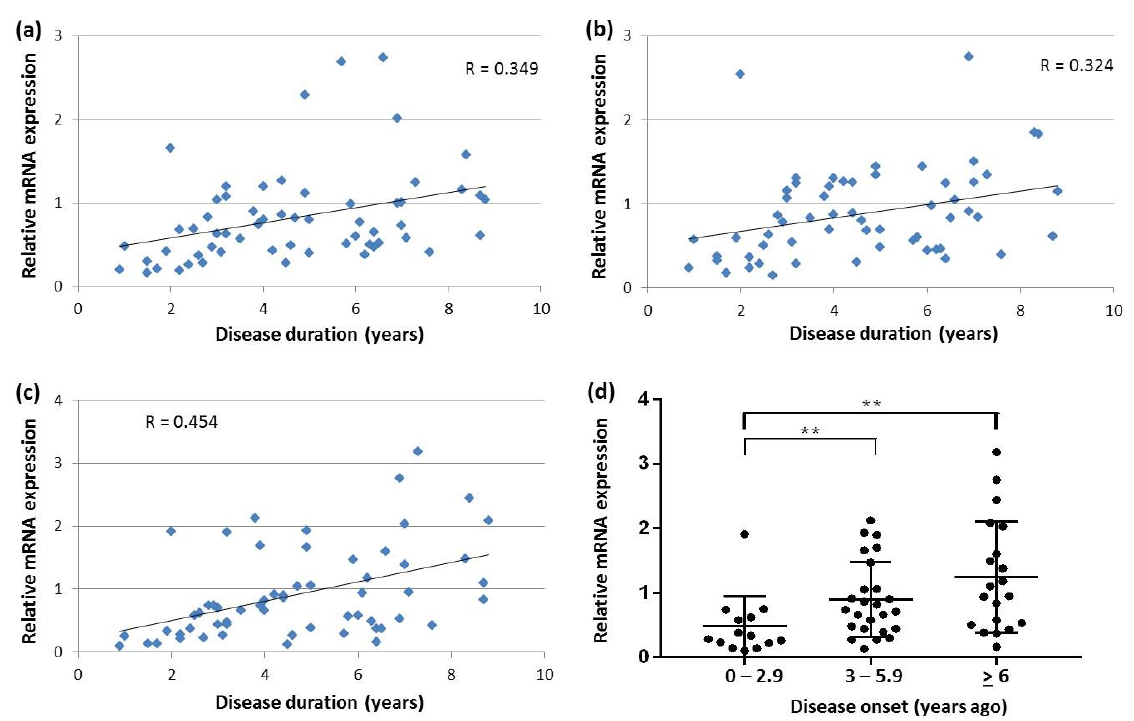
Figure 3. SNCA transcript expression in blood of DLB patients: ( a ) correlation between SNCAtv2 and disease dura- tion; ( b ) correlation between SNCA126 and disease duration; ( c ) correlation between SNCAtv3 and disease duration; ( d ) comparison of SNCAtv3 expression levels in three DLB groups with different disease duration. ** p